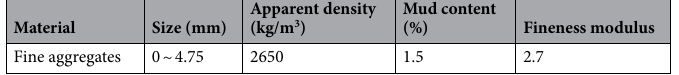
Table 3. Aggregate properties.